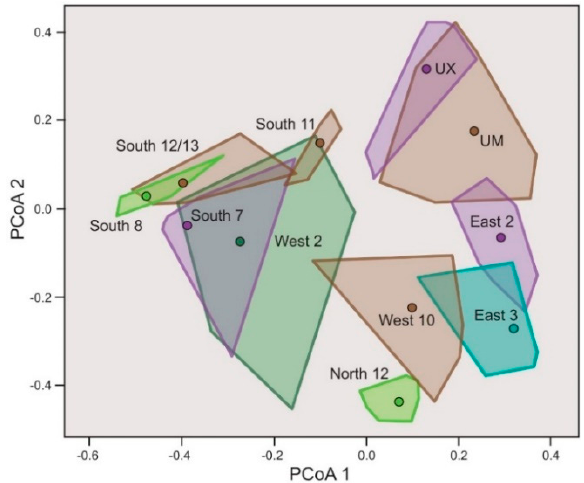
Figure 4. Shrub composition (species and abundance) ordination based on Bray-Curtis dissimilarities. Polygons delineate the range of data for the 11 disturbance categories in the Miller Creek Demonstration Forest (see Table 1 for descriptions).